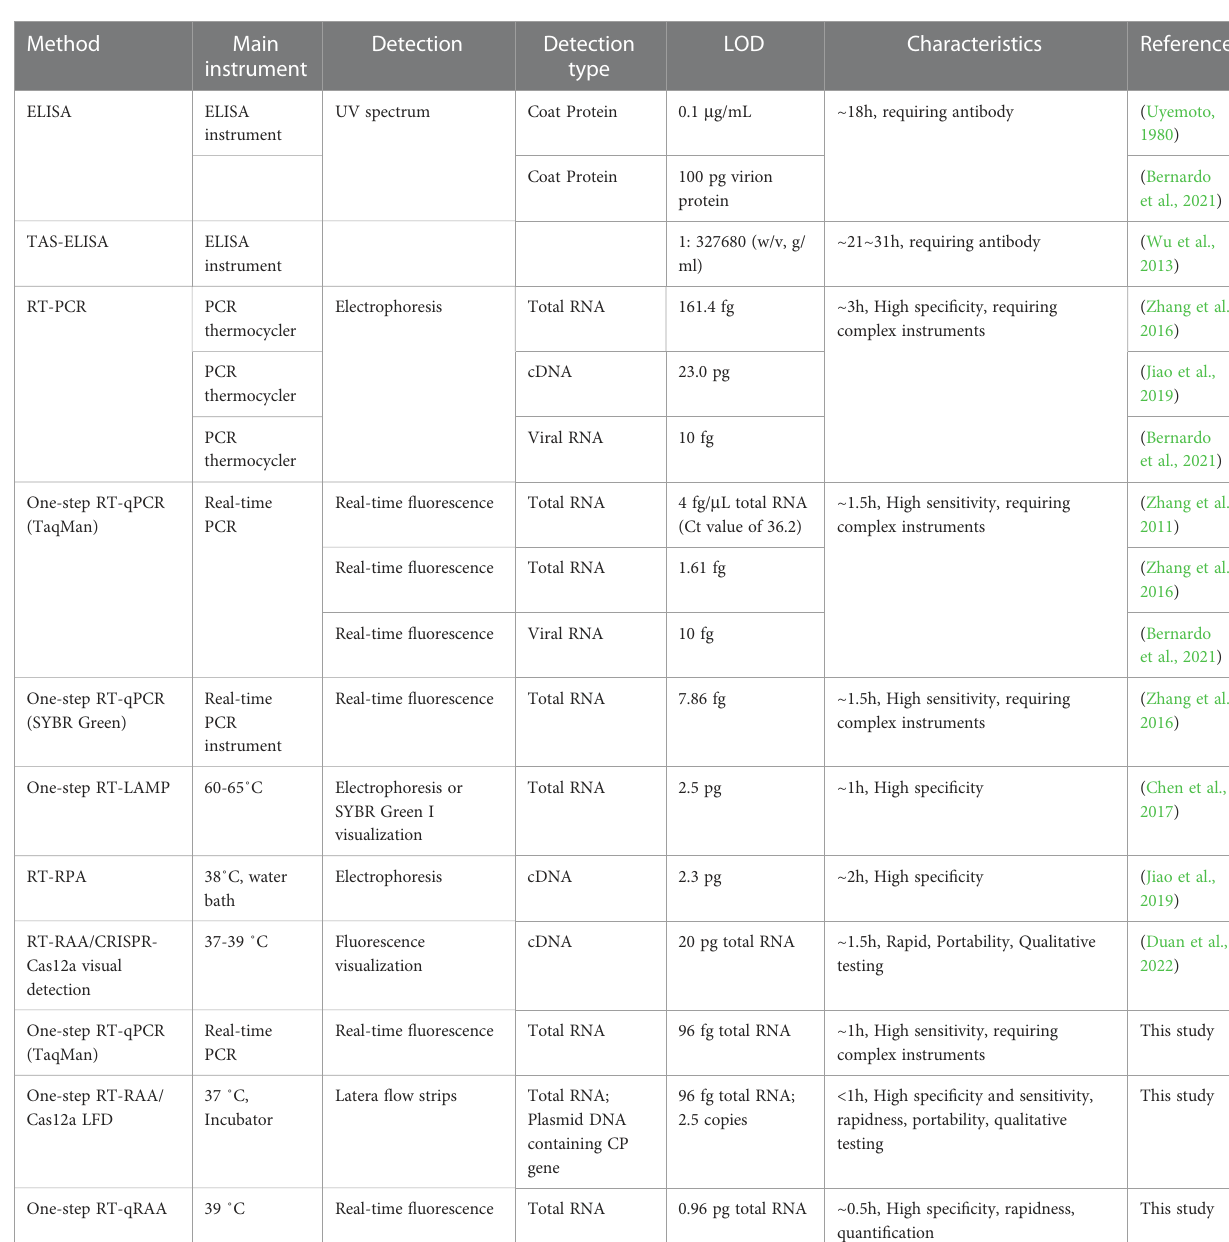
TABLE 2 Comparison of different detection methods for